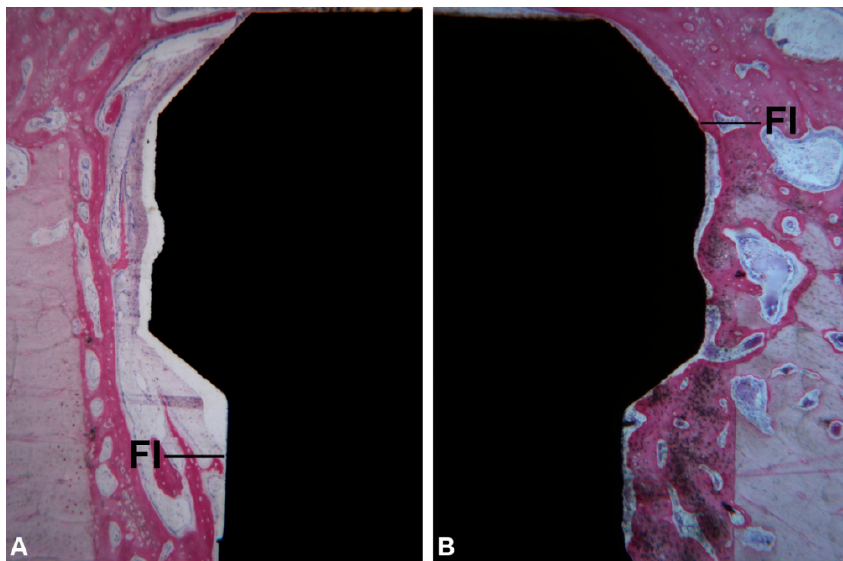
Figure 5. Cortical Compartment. These images showed the first bone implant contact (FI) in the coronal portion in Group 1 ( A ) and in Group 2 ( B ). New bone formation was observed in both groups, but in Group 2 it occurred more coronally than in the Group 1. (Acid fuchsin-Toluidine blue 18X). Int. J. Environ. Res. Public Health 2020 , 17 , x FOR PEER REVIEW